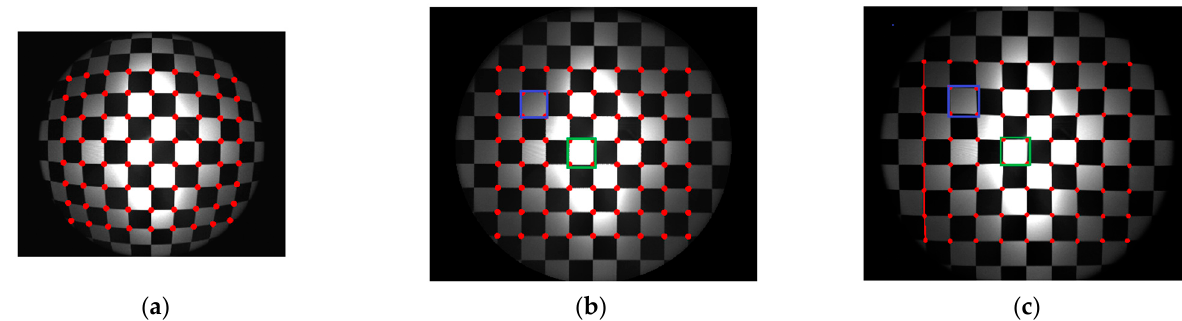
ners image, where the red asterisks represent the corners of the distorted checkerboard image and the blue points represent the corners of the corrected checkerboard image. The distortion displacement at the left top point is ∆ r = 198.94 pixels. The curvature radius of the red line formed by the left points on the distorted checkerboard image is 3.2457 × 10 3 pixels, and that of the blue line corresponding to the corrected checkerboard image is 6.8656 × 10 4 pixels. The larger the curvature radius, the closer the curve is to the straight line, i.e., the better the correction effect.